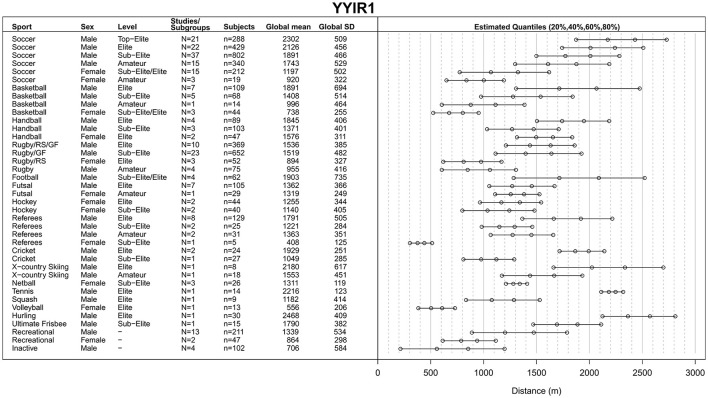
Yo-Yo Intermittent Recovery Level 1 (YYIR1) test results. RS, Rugby sevens; GF, Gaelic football.